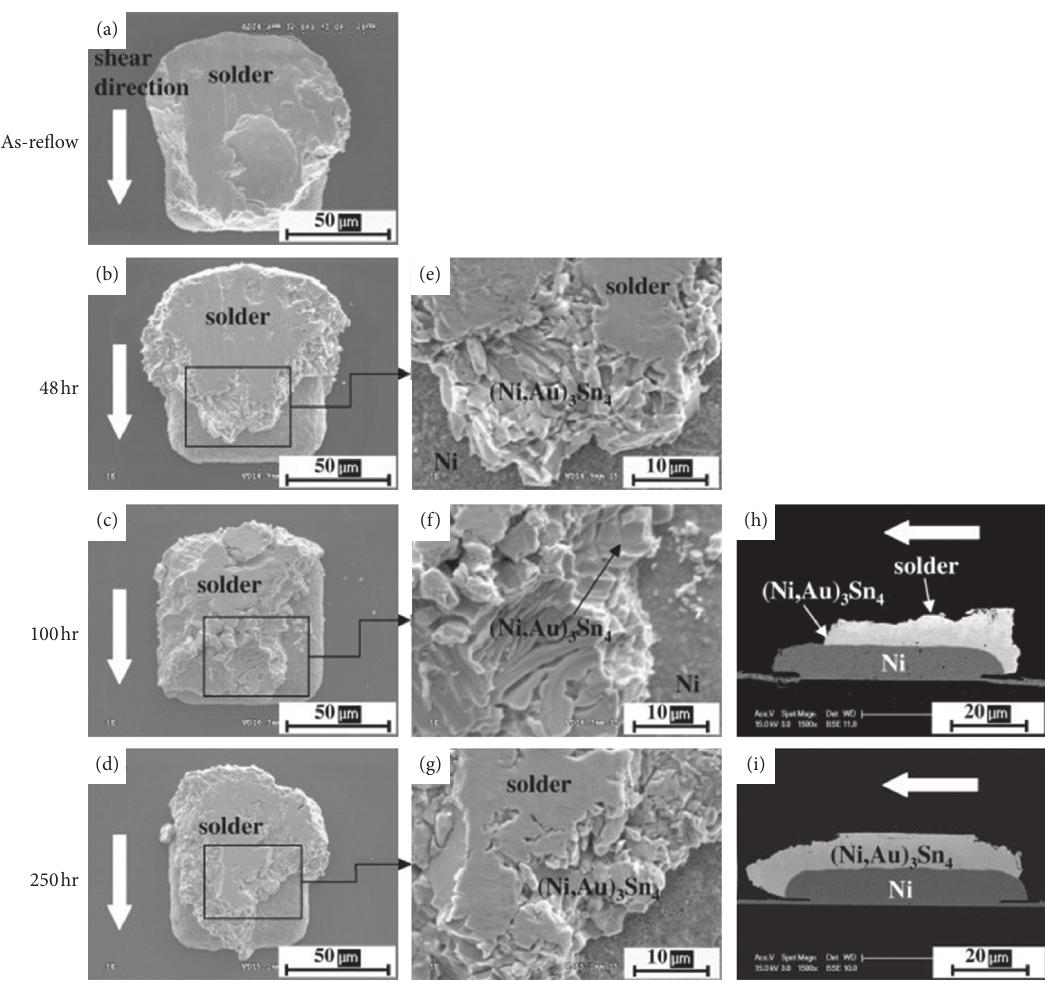
Figure 3: Top views and cross-sectional SEM images of the fracture surfaces of eutectic Au-Sn/Ni joints aged under various conditions [41]. 0.40.60.81.01.21.41.61.82.02.22.4 Figure 4: Shear force variation of Au-Sn/Ni solder bump with aging time